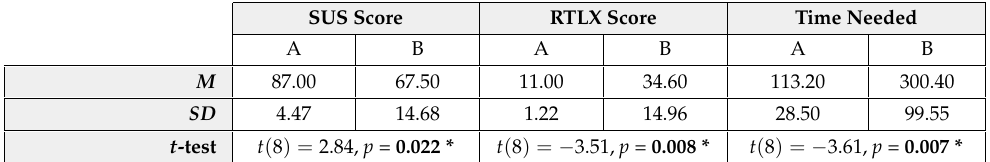
Table 4. T -test results of usability variables between